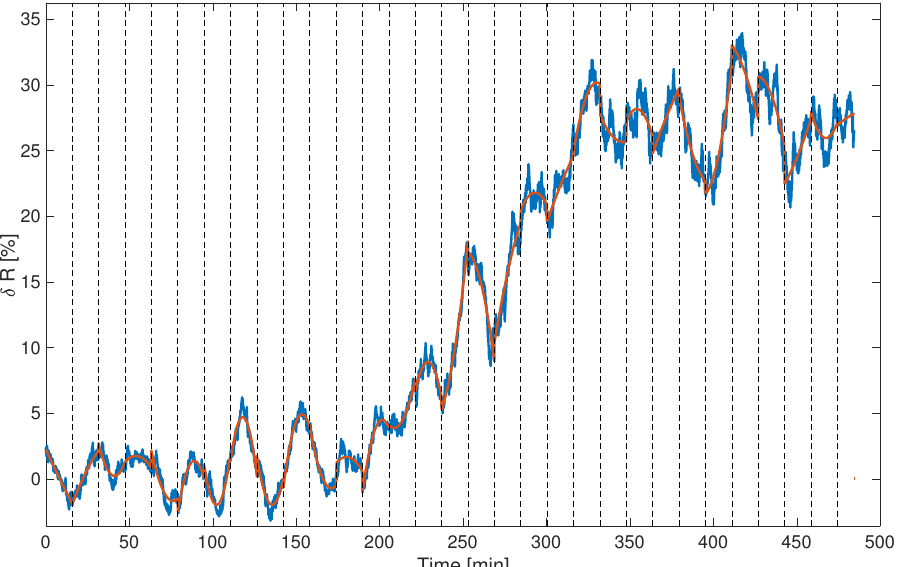
Figure 14. Exemplary learning results for the 25th